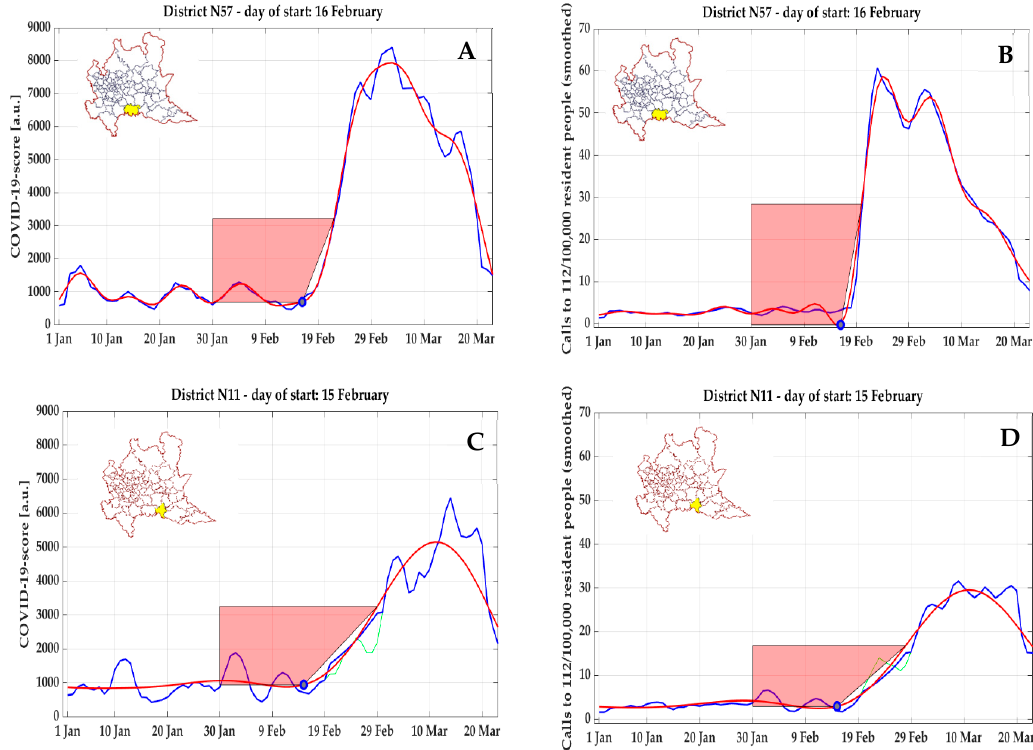
Figure 10. For the cluster including Codogno (#57): ( A ) COVID-19-score time series with identified inflection point (blue dot, see text for details); ( B ) normalized emergency calls (NEC, N calls / 100,000 residents) time series with identified inflection point. For the cluster including the nearby urban area of Cremona (#11): ( C ) COVID-19-score time series with identified inflection point; ( D ) normalized emergency calls (NEC, N calls / 100,000 residents) time series with identified inflection point. Early